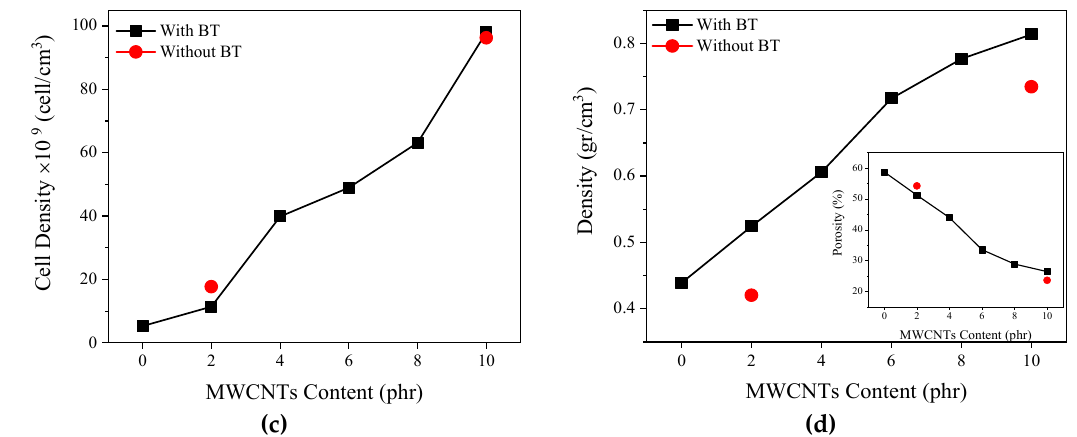
Figure 3. ( a ) Cells size distribution, ( b ) average cell size, ( c ) cell density, and ( d ) density; of ethylene-propylene-diene-monomer (EPDM)/multi-wall carbon nanotubes (MWCNT)/BT and EPDM/MWCNT foams containing different MWCNT loadings.